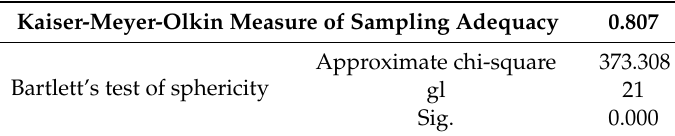
Table 7. KMO and Bartlett’s test.